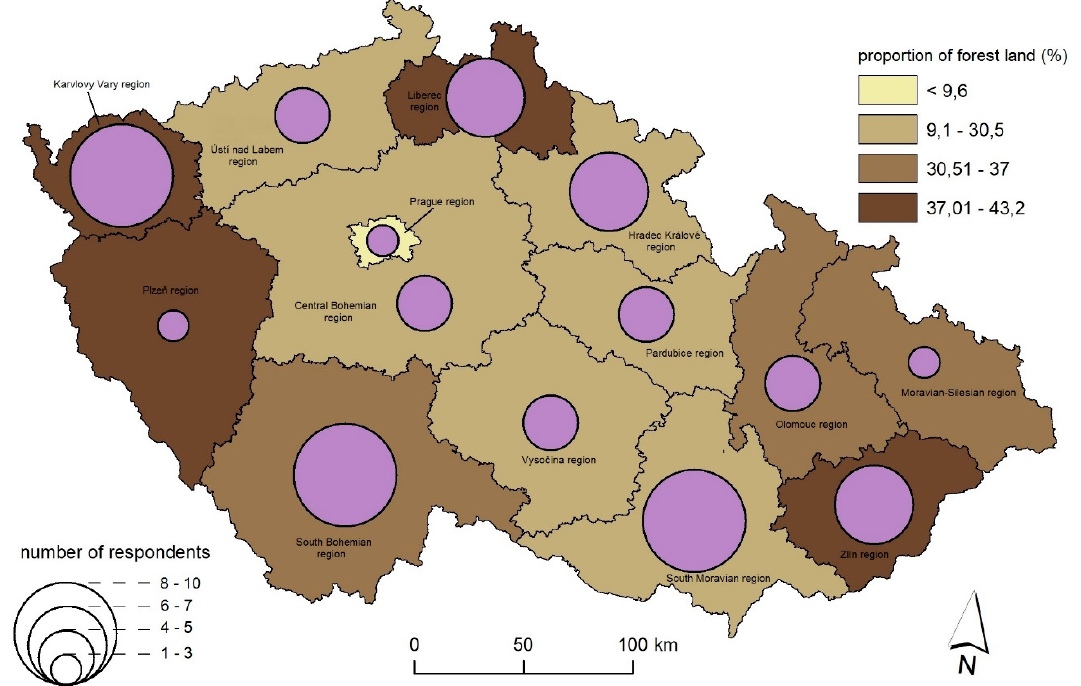
Figure 1. Number of respondents by Czech Republic region.